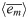
Motion change due to the presence of neural and force noises.(A, B) 〈de〉 and 〈em¯〉 with the parameters T = 10, K = 10, g = 0.02. (C) 〈de〉 with Dm = 0.01 and 〈em〉, with Dm = 0.05 as a function of Ds. (D) 〈ρ〉 and 〈No〉 as a function of Ds. (E, F) The change in motion trajectory due to the presence of neural and motion noises, with T = 10, K = 10, and g ≪ 1 [(E)] and g ≫ 0 [(F)]. The inset is an enlargement of the respective areas inside the rectangles. Note that the bias variability Db ≫ 0 leads to high pooling ability and reduces the oscillatory motion, but obscures the neuronal SR effect. Furthermore, the motion accuracy achieved due to neuronal SR (with Db ∼ 0 and Ds > 0) is higher than it is in the noiseless system with high motor pooling ability (with Db ≫ 0 and Ds = 0) (G). Numerical 〈de〉, 〈em¯〉, 〈ρ〉, and 〈No〉 are computed from 500 trials of a 500 s numerical simulation.